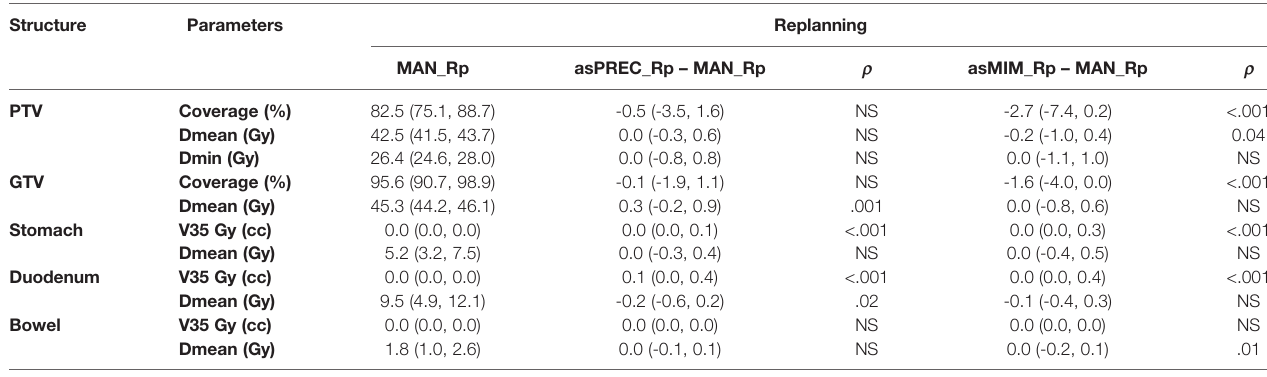
TABLE 3 | Median and interquartile range (Q1, Q3) plan parameters of the replanned doses based on autosegmented contours using precision (asPREC) and MIM (asMIM) vs. replanned doses based on manual contours (MAN). Structure